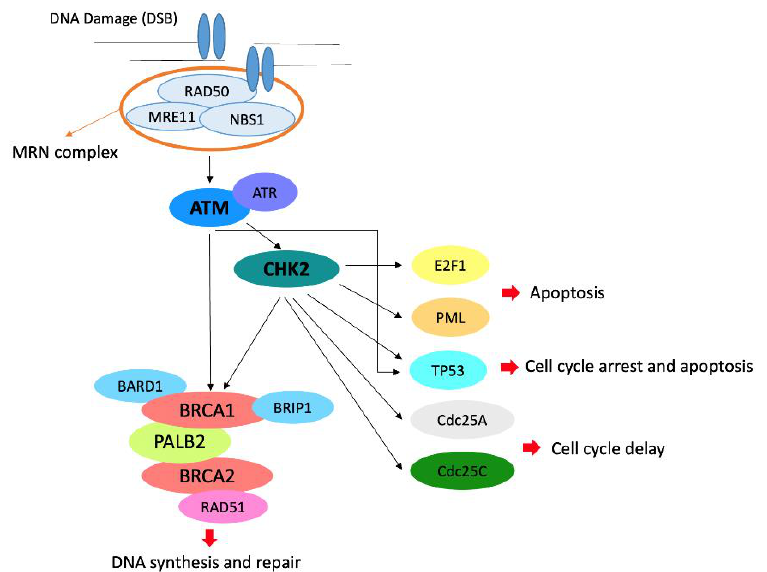
Figure 1. Role of ATM and CHK2 in the pathways of cell cycle arrest, apoptosis, DNA repair and mitosis. In particular, the MRN complex resects DNA at the double-strand break (DSB) and recruits ATM that phosphorylates CHK2 and recruits the BRCA complex.